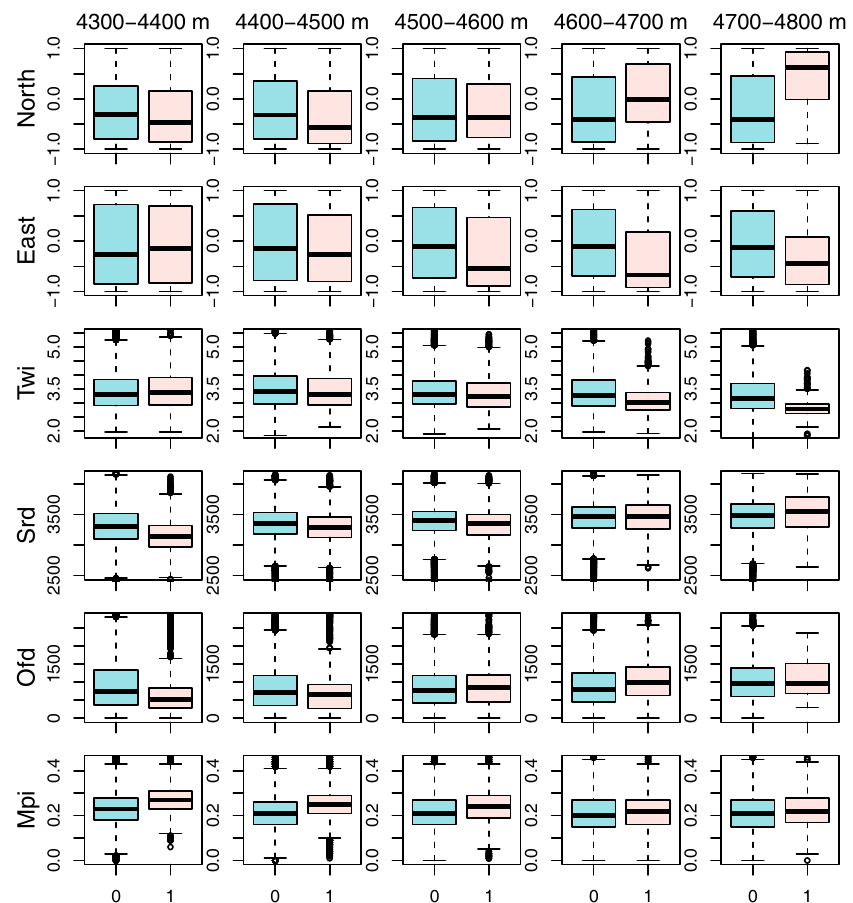
Figure 2. Boxplots of topographic variables explaining Polylepis subsericans forest stand distribution in the high Andes of southern Peru in five 100-m elevational bands. Light blue boxes: non- Polylepis (0), pink boxes: Polylepis (1). North = northern exposure, East = eastern exposure, Twi = topographic wetness index, Srd = annual solar radiation hours, Ofd = overland flow distance, Mpi = morphometric protection index.